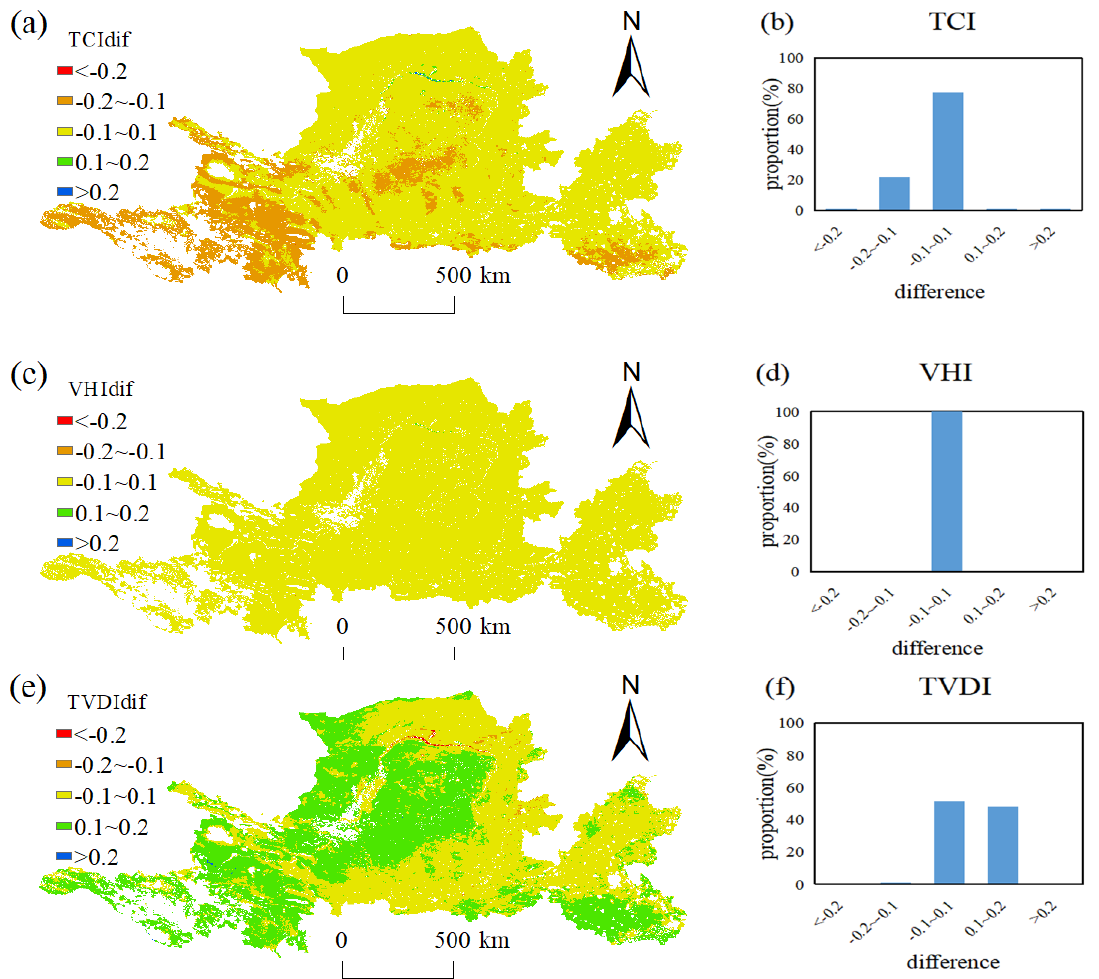
Figure 4. Statistics of the difference between ATC and MODIS drought indices. ( a ) Spatial distribution of TCI dif ; ( b ) percentage statistics of different TCI dif pixels; ( c ) spatial distribution of VHI dif ; ( d ) percentage statistics of different VHI dif pixels; ( e ) spatial distribution of TVDI dif ; ( f ) percentage statistics of different TVDI dif pixels.